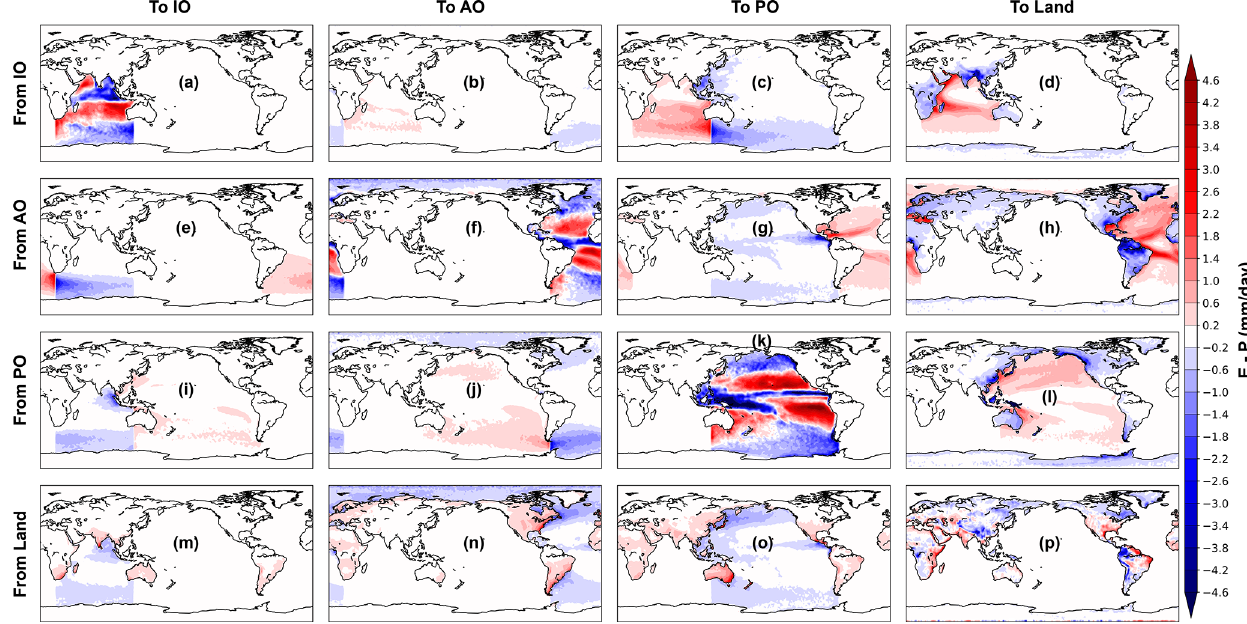
Figure 2. Annual mean E − P (mmd − 1 ) inferred from the atmospheric waters travelling from the surface net evaporative regions (red contours) to the net precipitation areas (blue contours). The rows represent the net evaporative (starting points of the atmospheric water trajectories) sectors and the columns represent the net precipitation (ending points of the trajectories) regions.